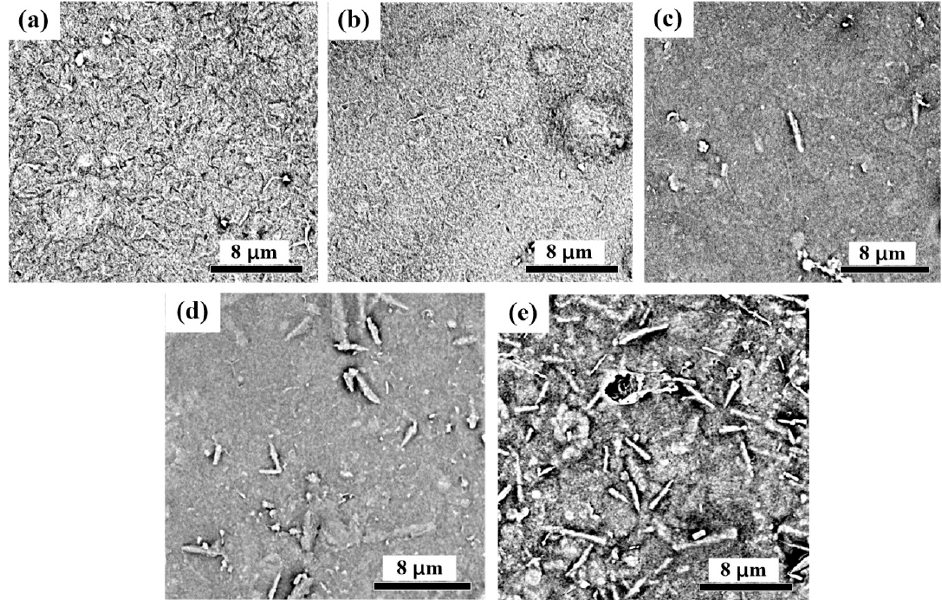
Figure 4. SEM images of the surfaces of CNF-AlN composites: ( a ) Pure CNFs; CNFs containing ( b ) 2% AlN, ( c ) 5% AlN, ( d ) 10% AlN, and ( e ) 20% AlN.